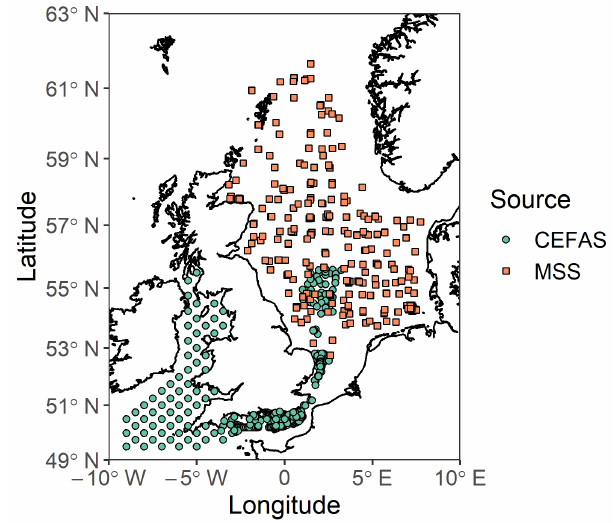
Figure 3. Sampling locations for sediment data obtained from CE- FAS and MSS for the statistical modelling of relationships between median grain size and fractions of mud, sand, and